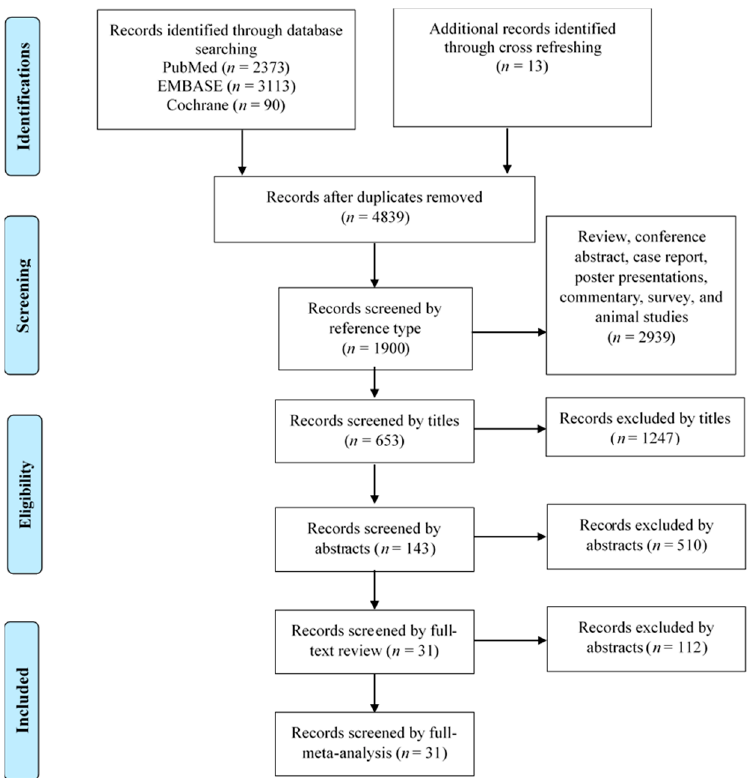
Figure 1. Flow chart for the study selection process.